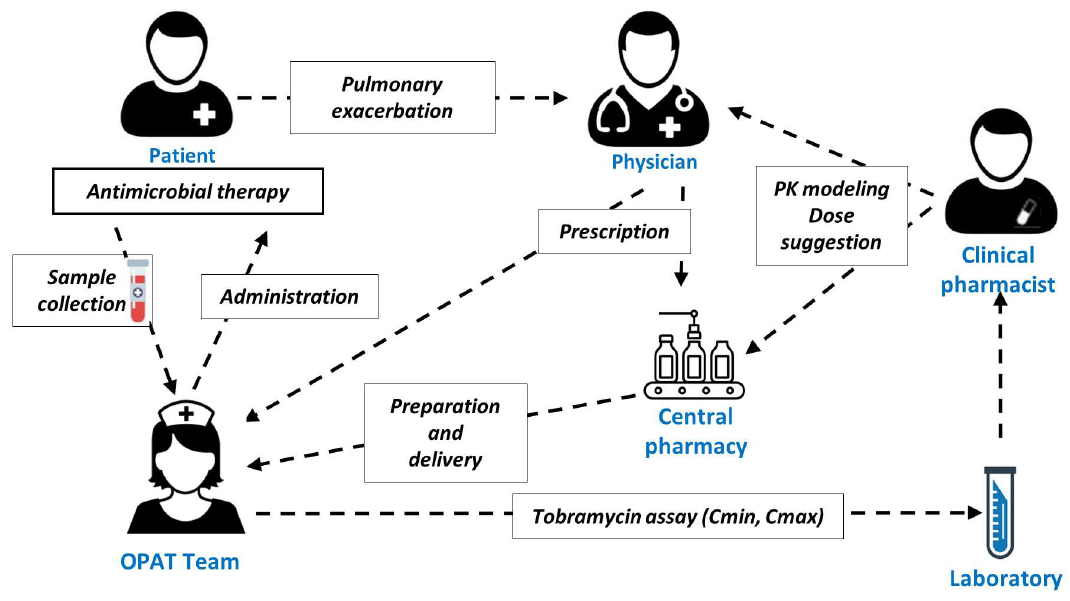
Figure 1. Organization of tobramycin therapy in our adult CF center. Abbreviations: Cmin, trough concentration; Cmax, maximal concentration; OPAT, outpatient parenteral antimicrobial therapy; PK, pharmacokinetics.